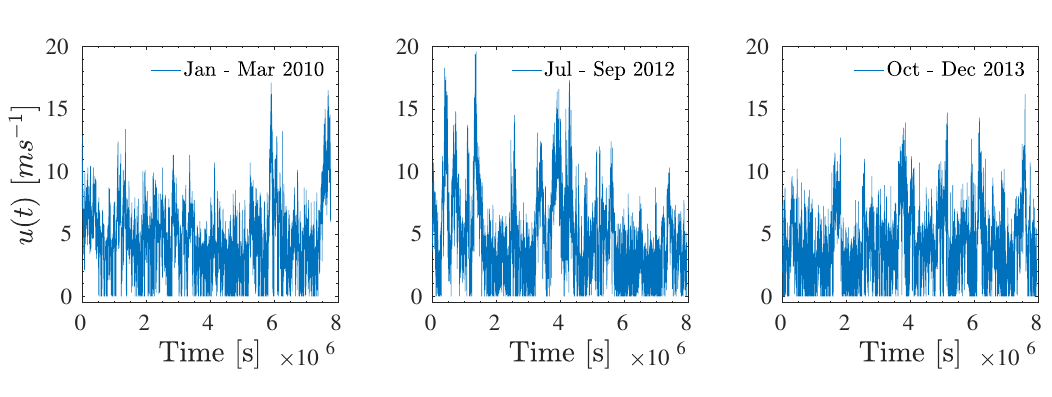
Figure 1. Three 90-day snapshots of wind speed u ( t ) time series relative to January–March 2010 ( left panel ), July–September 2012 ( central panel ), and October–December 2013 ( right panel ),